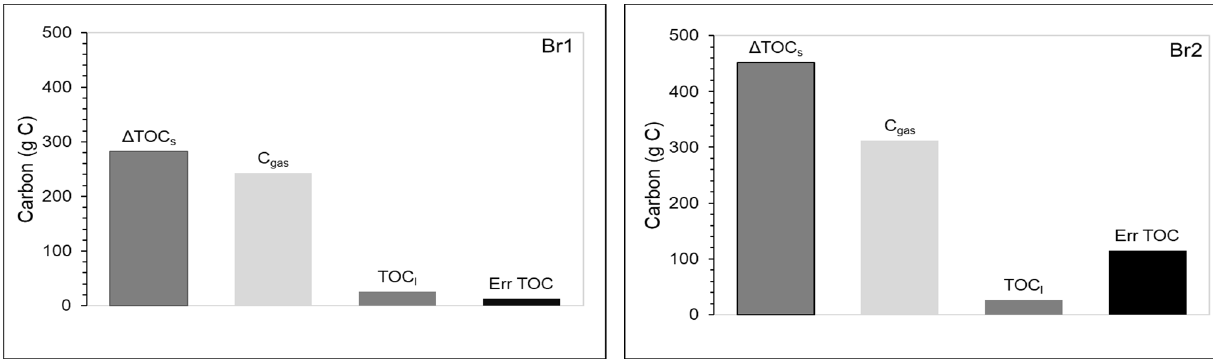
Figure 7. Changes in TOC content.